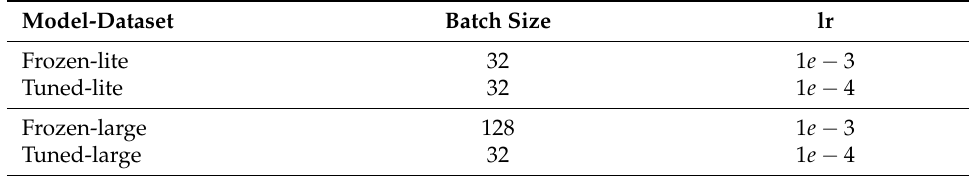
Figure 7. Training with different hyperparameters. On the left are the training curves with different batch sizes and learning rate of 0.001. On the right, different learning rates and batch size of 32. Table 13. Hyperparameters used in